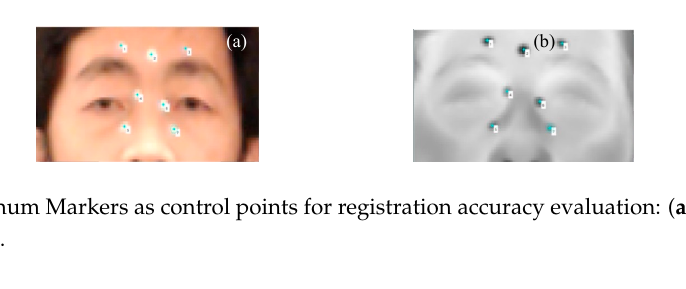
Figure 6. Checkered view of registered images using the ( a ) coarse, ( b ) coarse-Demons, and ( c ) coarse-spline methods.